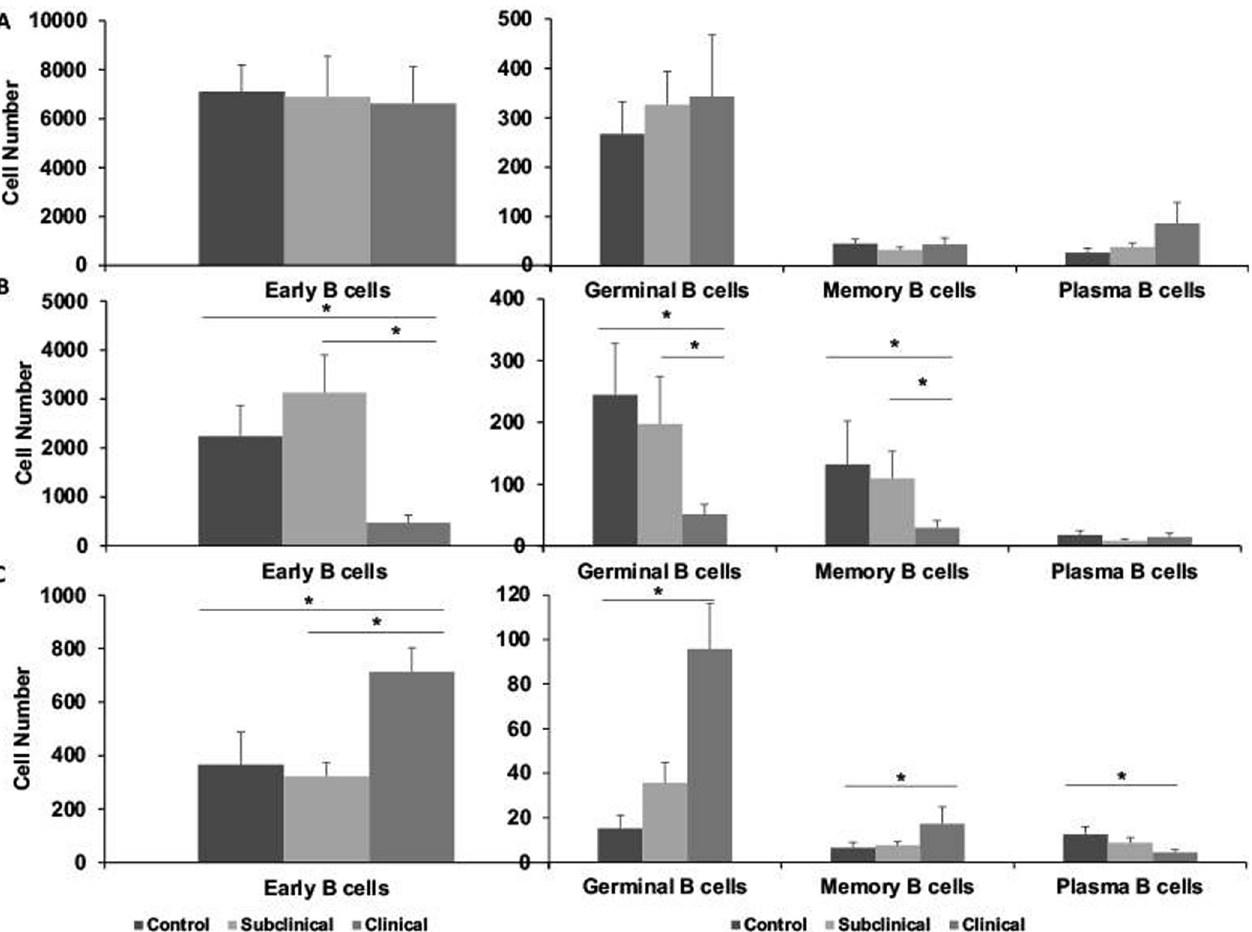
Fig 6. Flow cytometric staining of PBMCs isolated from blood of noninfected control cows and cows naturally infected with M . avium subsp. paratuberculosis to separate B cells by stage of maturity. Partitioning of B cells into maturation states of early B cells, germinal B cells, memory B cells, and plasma cells was performed using combinations of antibodies referenced in Table 1. PBMCs were isolated (A); stimulated with pokeweed mitogen (B; 10 μ g/ ml) for 3 days; or with a whole cell sonicate (MPS) of M . avium subsp. paratuberculosis (C; 10 μ g/ml) for 6 days in